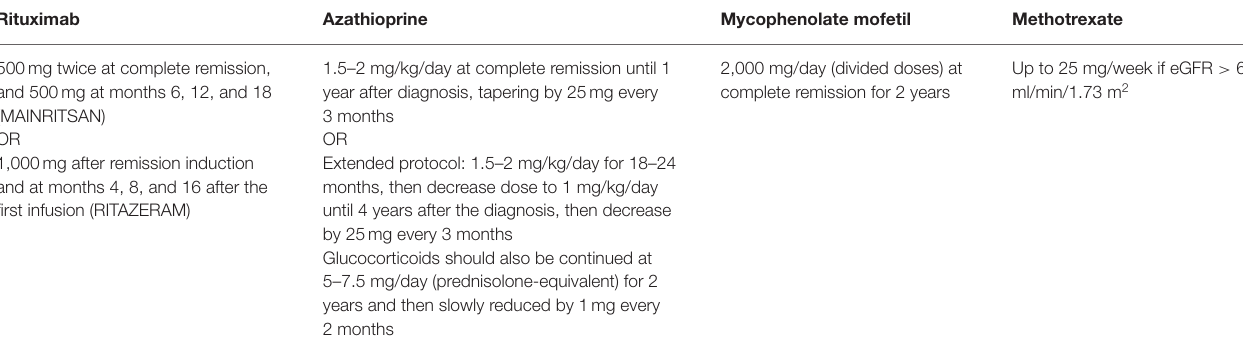
TABLE 3 | Immunosuppressive maintenance therapy in ANCA-associated glomerulonephritis according to the KDIGO 2021 Clinical Practice Guideline for the Management of Glomerular Diseases (43). Rituximab Azathioprine Mycophenolate mofetil Methotrexate 500mg twice at complete remission, and 500mg at months 6, 12, and 18 (MAINRITSAN) OR 1,000mg after remission induction and at months 4, 8, and 16 after